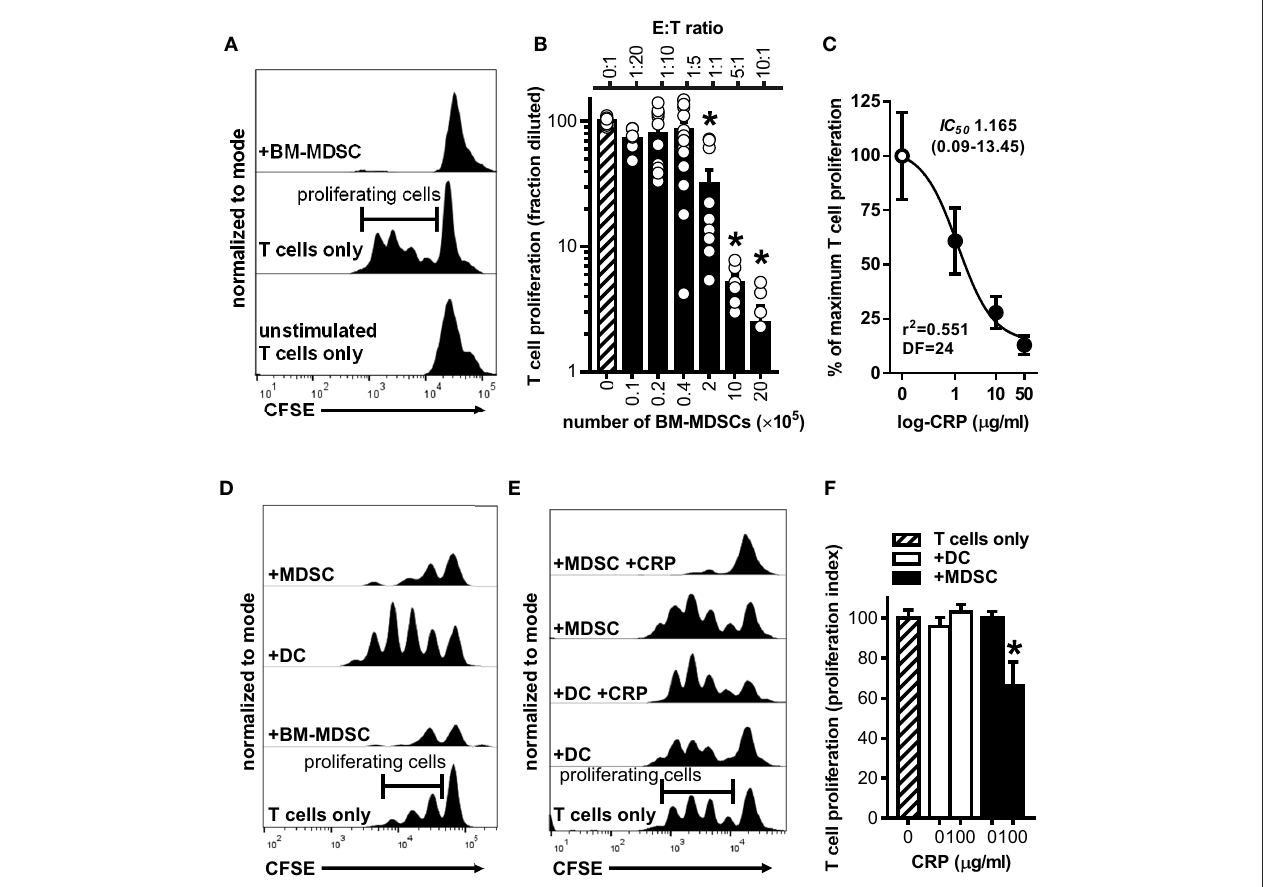
FIGURE 3 | Human CRP enhances the suppressive capacity of mouse MDSCs. Mouse MDSCs were used in co-cultures with mouse T cells to assess their suppressive capacity and the effect of human CRP on MDSC mediated immune suppression. (A) Representative CFSE dilution histograms (normalized to mode as defined in the Materials and Methods ) for CD4 + T cells cultured without stimulation and in isolation (bottom trace), cultured with stimulating anti-CD3 and anti-CD28 mAbs but in isolation (middle trace; horizontal gate used to demarcate proliferating cells is shown), or co-cultured with BM-MDSCs (10E:1T) in the presence of stimulating anti-CD3 and anti-CD28 mAbs (top trace). Note that in the presence of BM-MDSCs proliferation of T cells is suppressed. See Supplemental Figure 2 for additional details. (B) Pooled results (mean + SEM fraction diluted for n = 2–5 co-cultures each conducted in triplicate) from experiments performed with (i) co-cultures of BM-MDSCs plus CFSE-labeled T cells in the presence of stimulating anti-CD3 and anti-CD28 mAbs (solid bars; experiments done as in the top trace of (A) but with increasing E:T ratios) or with (ii) CFSE-labeled T cells cultured without BM-MDSCs but with stimulating anti-CD3 and anti-CD28 mAbs (cross-hatched bar; experiments done as in the middle trace of A ). The asterisks indicate p < 0.0001 for Dunnett’s tests compared to the proliferation of the CD3/CD28 stimulated T cells (cross-hatched bar). At E:T ratios of 1:1 or more BM-MDSCs significantly suppressed T cell proliferation. (C) Suppression assays were done using BM-MDSCs plus CD3/CD28 stimulated T cells (5E:1T ratios as in B ), and T cell proliferation in the absence of CRP or in the presence of 1–50 µ g/ml human CRP was measured. Addition of human CRP dose-dependently enhanced the ability of mouse BM-MDSCs to suppress T cell proliferation. The IC 50 and associated 95% confidence interval estimated by non-linear regression analysis is indicated ( r 2 = 0.551, DF = 24 obtained from two separate co-cultures each done in triplicate). (D) Representative CFSE dilution histograms (normalized to mode) for mouse CD4 + T cells stimulated with anti-CD3 and anti-CD28 mAbs; from bottom to top the